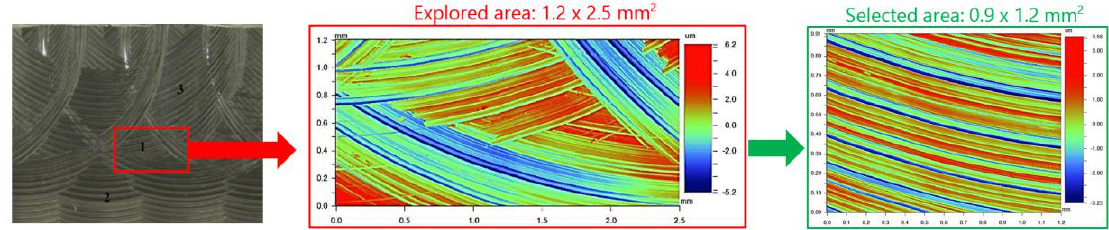
Figure 9. Areas of 3D surface measurement on horizontal machined surfaces.